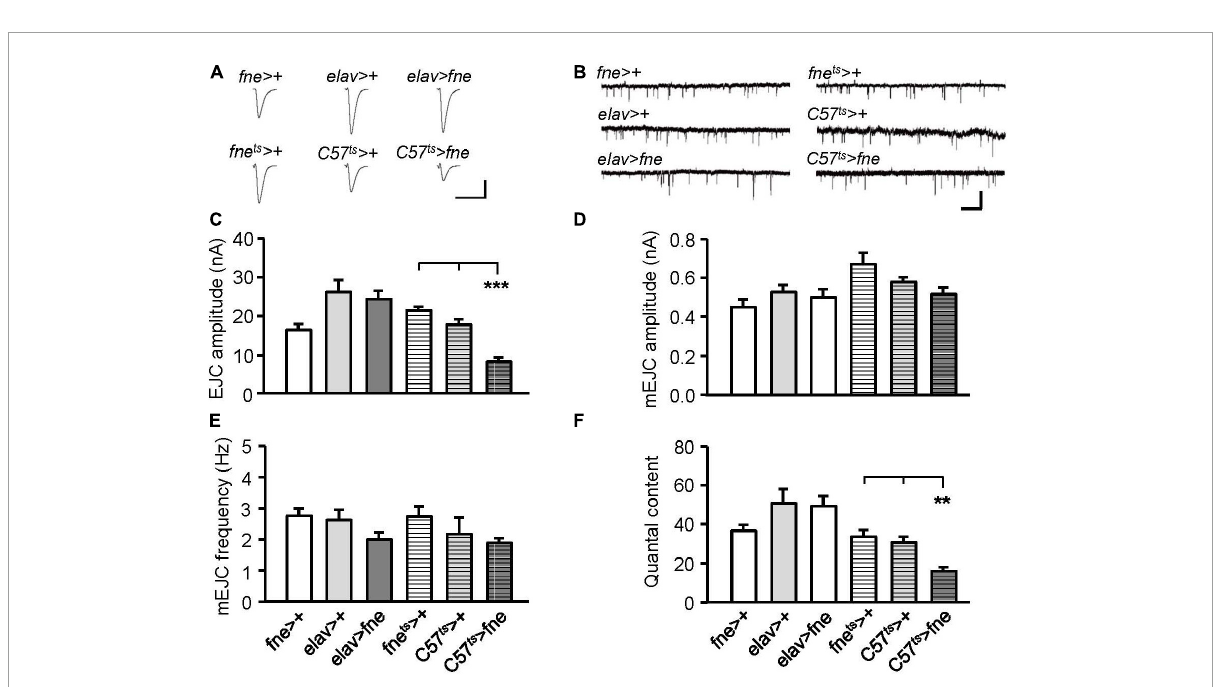
FIGURE4 Overexpression of fne in muscle cells altered synaptic transmission in the larval NMJ. (A) Representative traces of EJC in the indicated genotypes. Calibration: 10 nA, 50 ms. (B) Representative traces of mEJC in the indicated genotypes. Calibration: 1 nA, 1 s. Quantification of (C) EJC amplitude, (D) mEJC amplitude, (E) mEJC frequency, and (F) quantal content. Bars with horizontal lines represented the flies that were reared at 18 ◦ C and shifted to 29 ◦ C for 1 day to induce fne expression. Error bars represent SEM. ** p < 0.01, *** p < 0.001, n = 8 for each